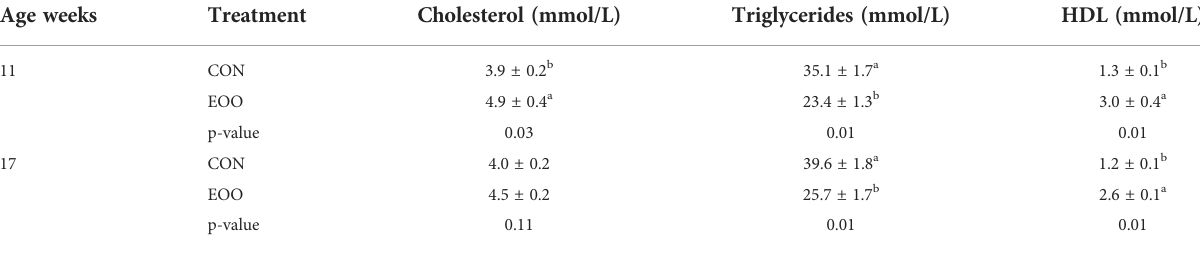
TABLE 6 Blood lipid pro fi le parameters of pullets at 11 and 17 weeks of